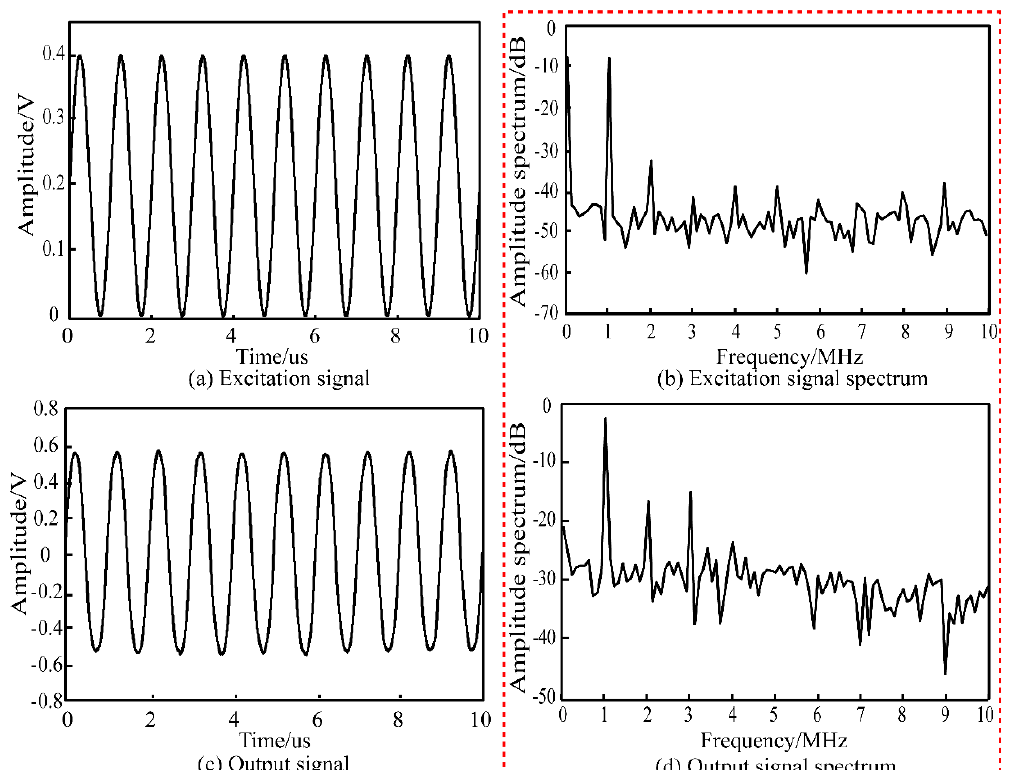
Figure 7. The time-domain and frequency-domain waveforms of the experimental signals: the ( a ) excitation signal; ( b ) excitation spectrum; ( c ) output signal; and ( d ) output signal spectrum.